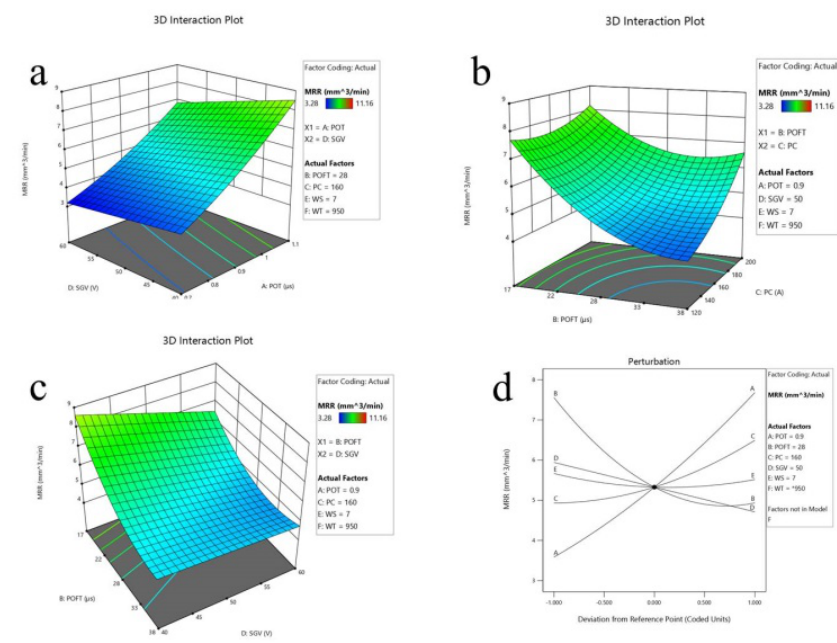
Figure 3: 3-D Response surface interaction and Perturbation plot